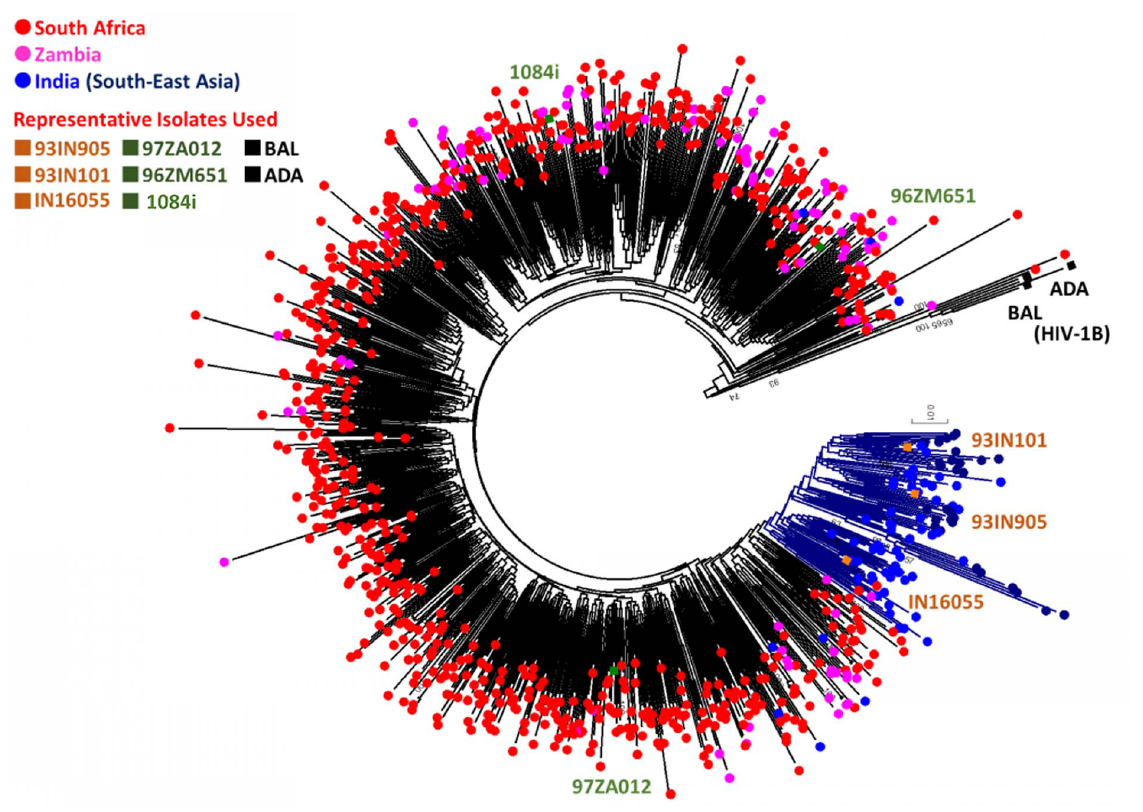
Figure 1. Phylogenetic analysis of gp120 sequences. Neighbor-joining phylogenetic tree was constructed in MEGA 6.06 software using 878 HIV-1C and four HIV-1B (as outlier) gp120 sequences from India and from the Southern African Countries of South Africa and Zambia. Due to the comparatively fewer HIV-1C gp120 sequences that were available from India, we included HIV-1C gp120 sequences from China and Myanmar that were available in the database. A separate phylogenetic tree with HIV-1C gp120 sequences from China, Myanmar confirmed their Indian origin. HIV- 1B sequences from US were included in the phylogenetic analysis for comparison. Bootstrap values . 50% were shown in the tree. The HIV-1C gp120 sequences from India and Southern African countries are genetically distinct and cluster separately. The specific isolates used in our in-vitro analysis (HIV-1 ADA , HIV-1 Bal , HIV-1 IndieC1 , HIV-1 93IN905 , HIV-1 IN16055 , HIV-1 1084i , HIV-1 97ZA012 and HIV-1 96ZM651 ) are included in this analysis (and indicated on the diagram) to show that they qualify to be used as representative isolates.